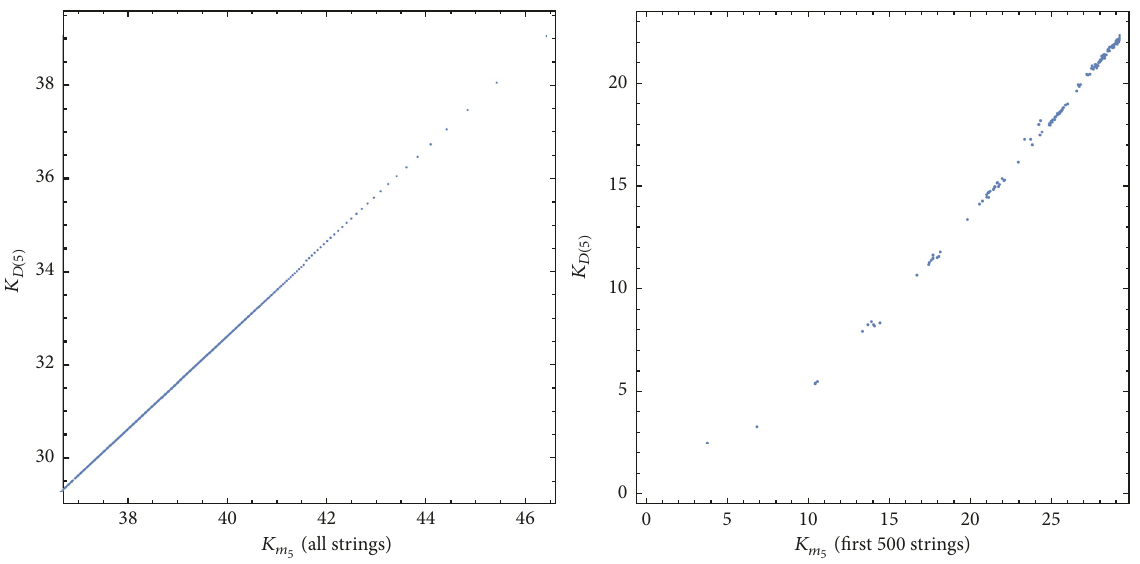
Figure 1: Correlation of rank comparison between 𝐾 𝑚